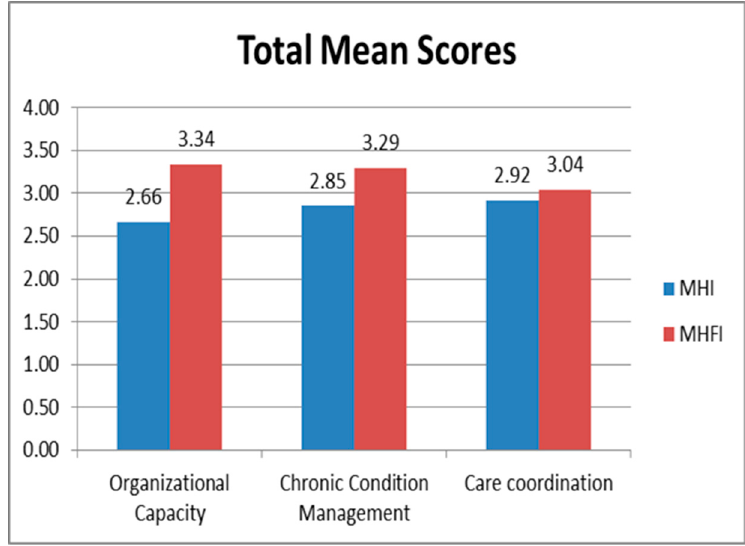
Figure 1. Medical home rating scales comparison of practice staff and family ratings on key medical home components.